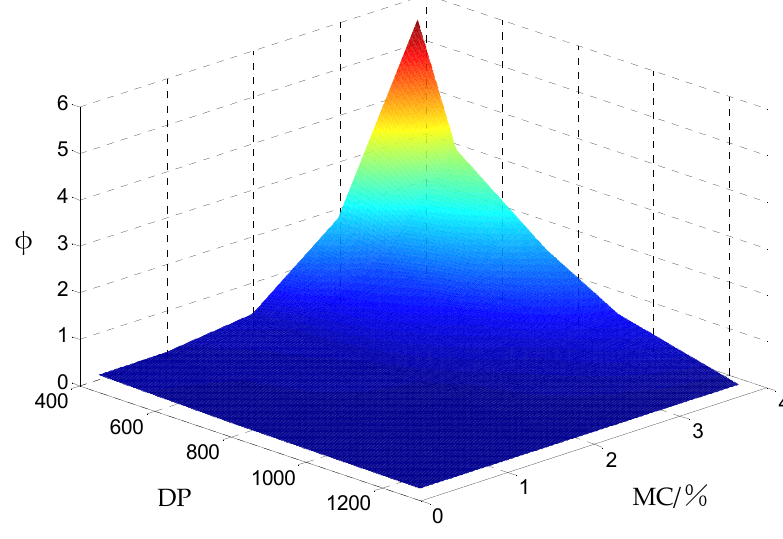
Figure 8. Fitting surface of aging compensation factor.